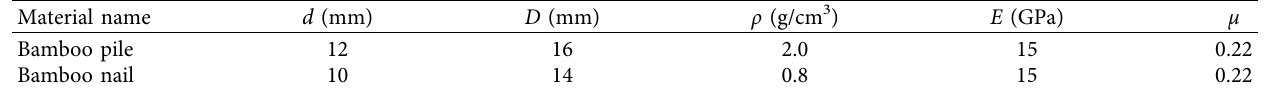
Figure 2: Layout of the foundation pit. (a) Pit plan. (b) Foundation pit profile. Table 2: Basic parameters of supporting materials.